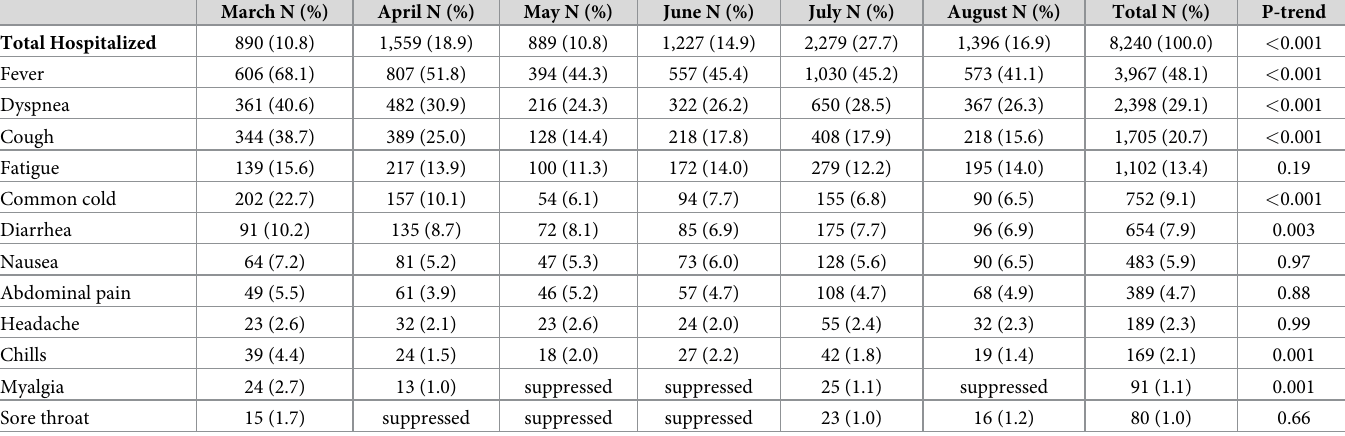
Table 2. Patient symptoms � among 8,240 hospitalized Veterans Health Administration users with coronavirus disease 2019 (COVID-19), March 1, 2020 –August 31,